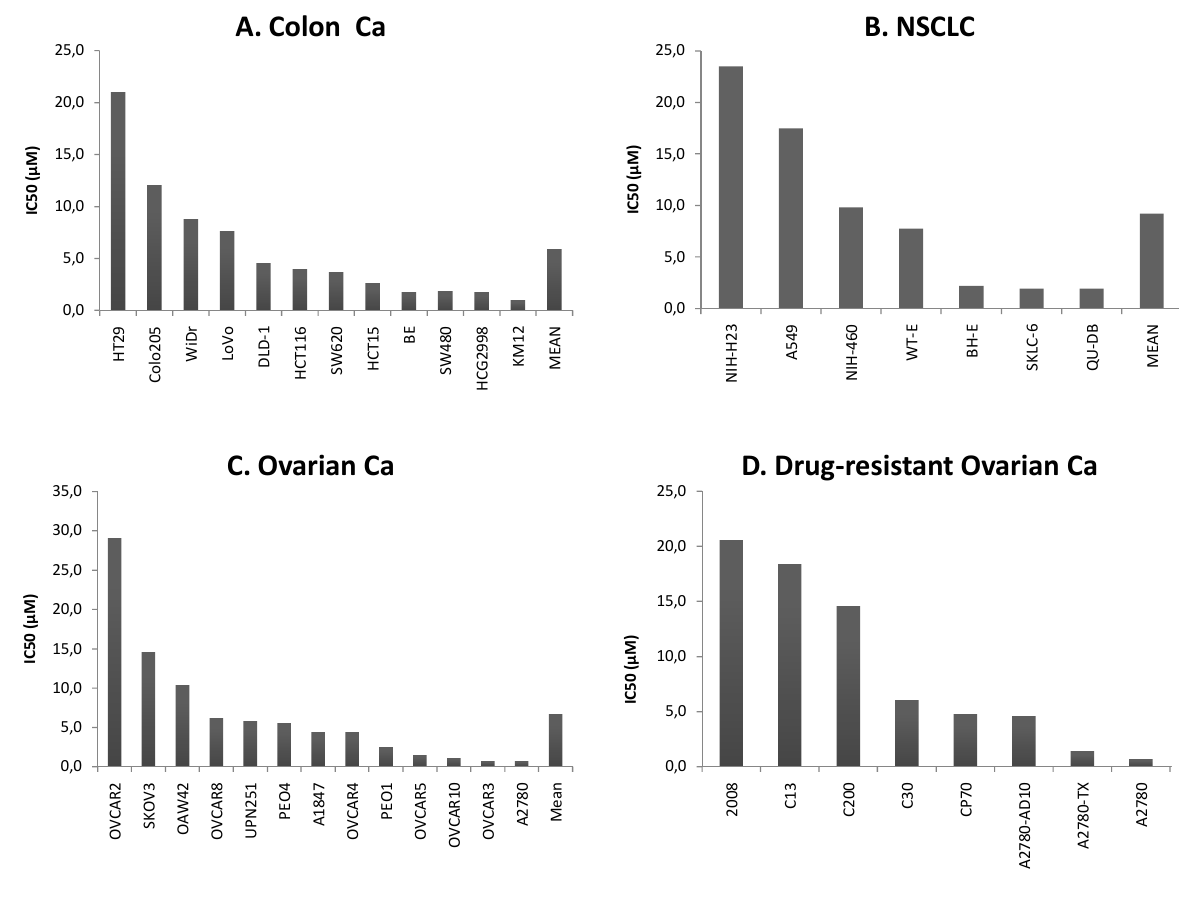
Figure 1. Ranked order of IC values for ART in 39 human cell lines of three different 50 anatomical locations. (A) Colon cancer cell lines, (B) non-small cell lung cancer (NSCLC) cell lines, (C) ovarian cancer cell lines, and (D) sensitive ovarian cell lines and sublines resistant to cisplatin, adriamycin, or